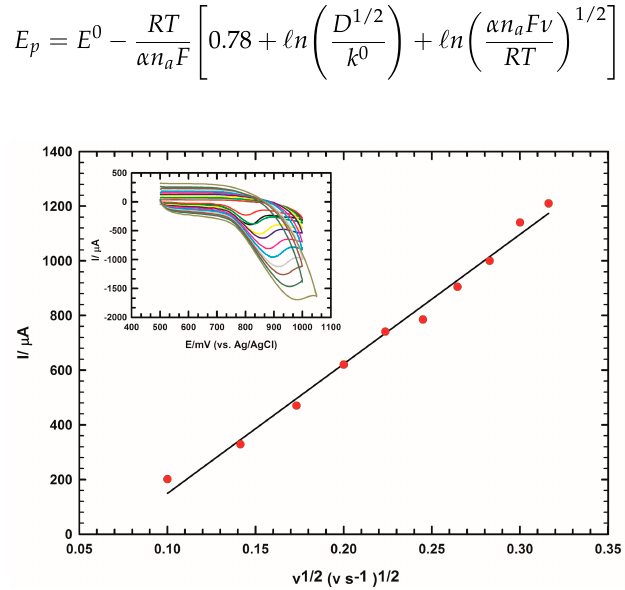
Figure 4. The linear relation between the anodic peak current of TZ ( µ A) and the square root of the scan rate (mV·s − 1 ) 1/2 , the inset, CVs of 1 mmol·L − 1 TZ/0.1 mol·L − 1 PBS/pH 7.40 at ILCCPE…SDS at different scan rates (10–100 mV·s − 1 ).